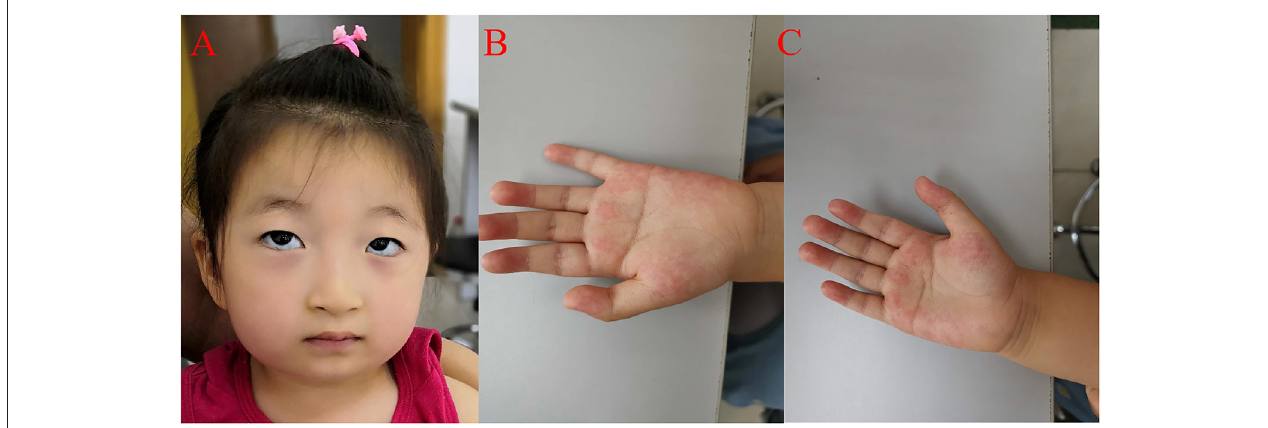
FIGURE 2 | Clinical features of the proband. (A) The proband presented with micrognathia, wave-shaped eyes, short philtrum, thick eyelashes and thick hair. (B) Left coherent palm with hyperlinearity. (C) Hyperlinear right palm.